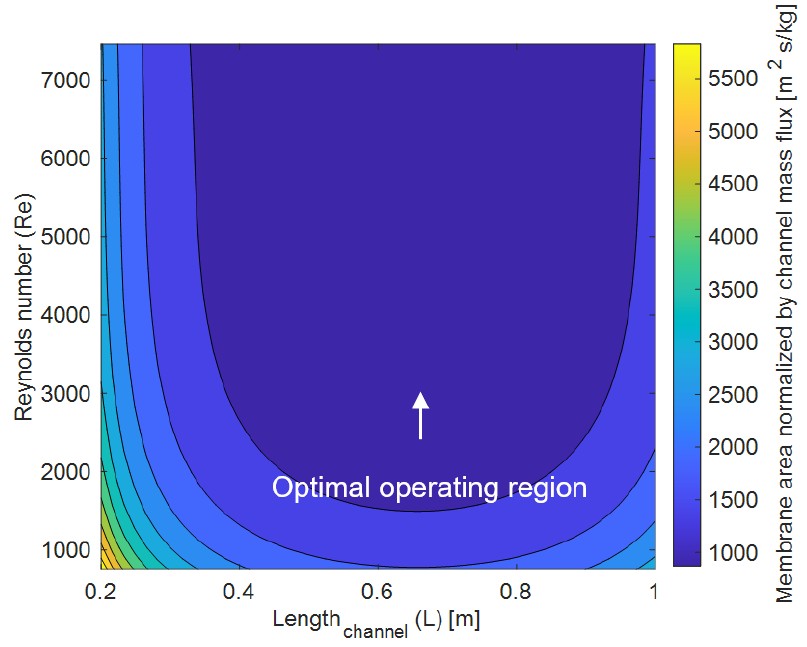
Figure 7. Membrane surface area requirements. T in = 27 ◦ C, RH in = 70%, T coil = 10 ◦ C, H = 0.006 m, N coils = 8, d = 0.003 m, h cs = 0.006 m. B = 5000 GPU while the horizontal coil spacing is varied to accommo- date 8 coils depending on the channel length. W is varied to produce J/A membrane = 0.00005 kg/s.